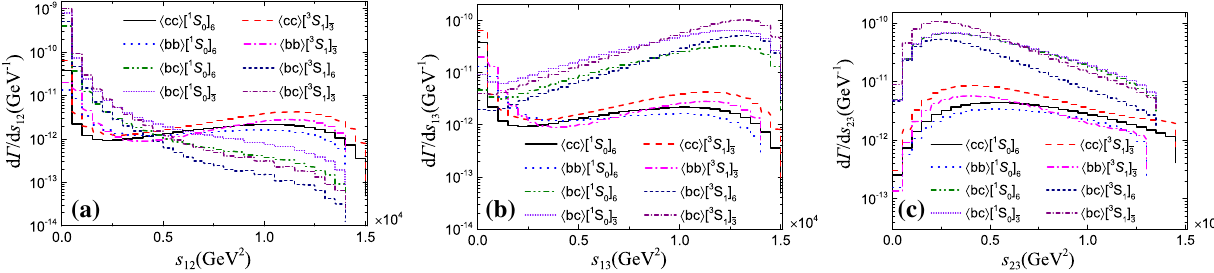
Fig. 2 The invariant mass differential decay widths d (cid:6)/ d s 12 ( a ), d (cid:6)/ d s 13 ( b ) and d (cid:6)/ d s 23 ( c ) for the process H 0 → (cid:2) QQ (cid:3) + ¯ Q (cid:3) + ¯ Q . Eight lines represent the possible spin and color configurations, i.e., (cid:4) cc (cid:5)[ 1 S 0 ] 6 , (cid:4) cc (cid:5)[ 3 S 1 ] ¯